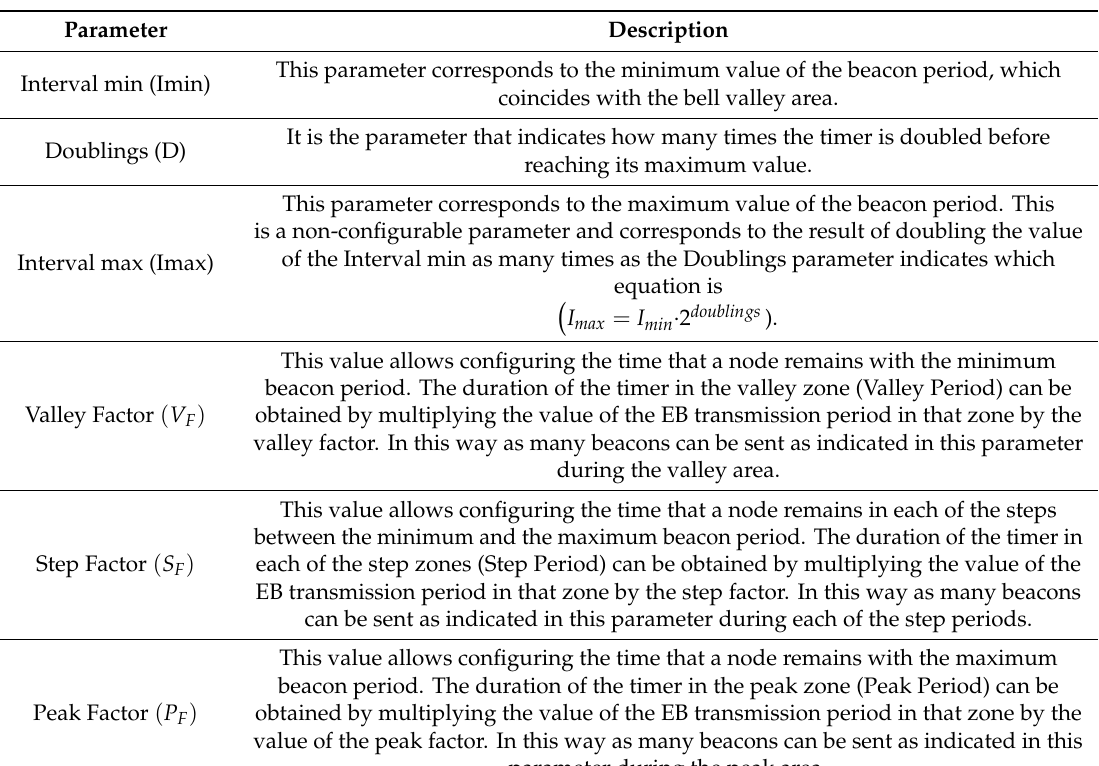
Table 2. Configuration parameters for the proposed dynamic